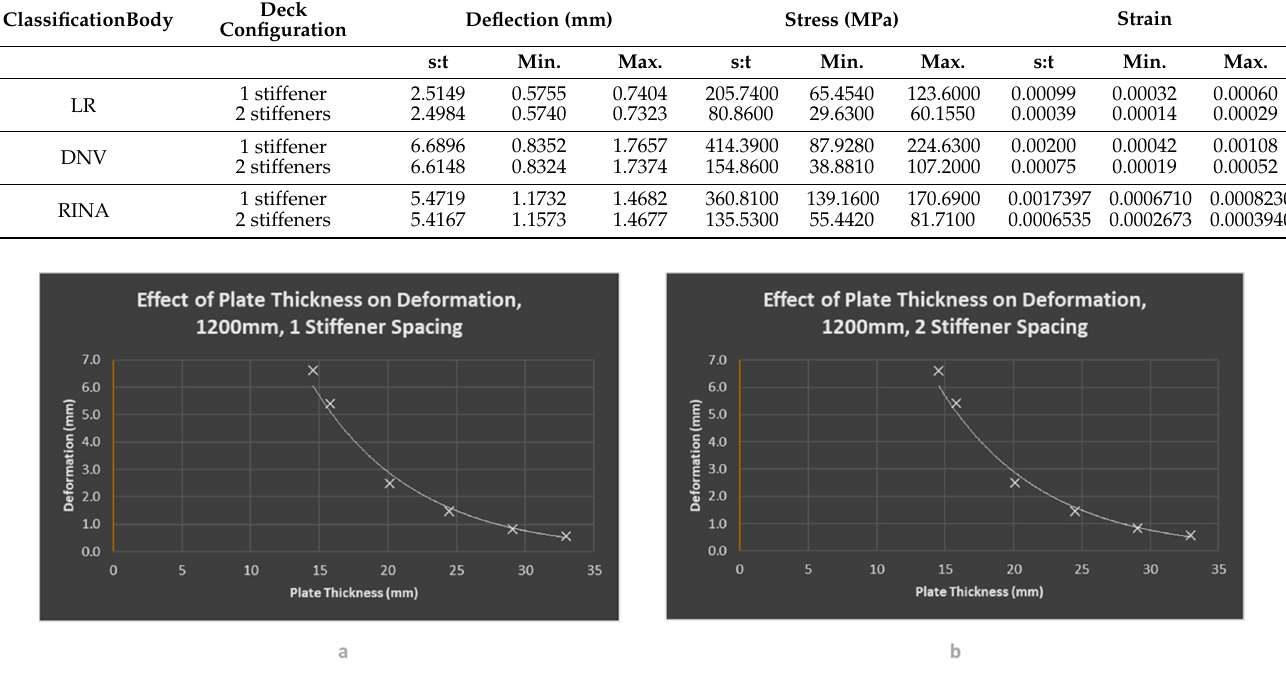
Figure 12. Maximum deformation as a function of plate thickness under the UDL condition. ( a ) Deck plate with one stiffener; ( b ) deck plate with two stiffeners.